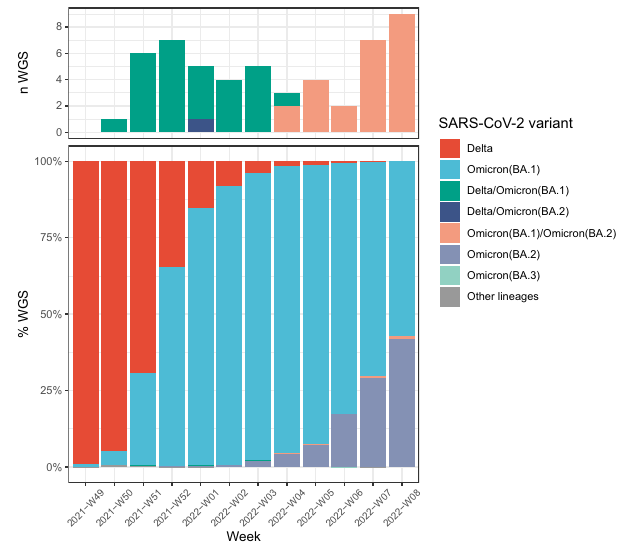
Fig. 4 | Number of Delta/Omicron (BA.1), Delta/Omicron (BA.2) and BA.1/BA.2 co-infections during Delta, Omicron(BA.1),and Omicron(BA.2) co-circulation in France. Colors indicate lineages: Delta (B.1.617.2 and AY.* lineages) in red, Omicron (BA.1) in blue, Omicron (BA.2) in purple, Omicron (BA.3) in light blue, otherlineages(includingB.1.640.1)ingrey.Co-infectionsbetweenDelta/BA.1arein green, Delta/BA.2 in dark blue, and BA.1/BA.2 in salmon.